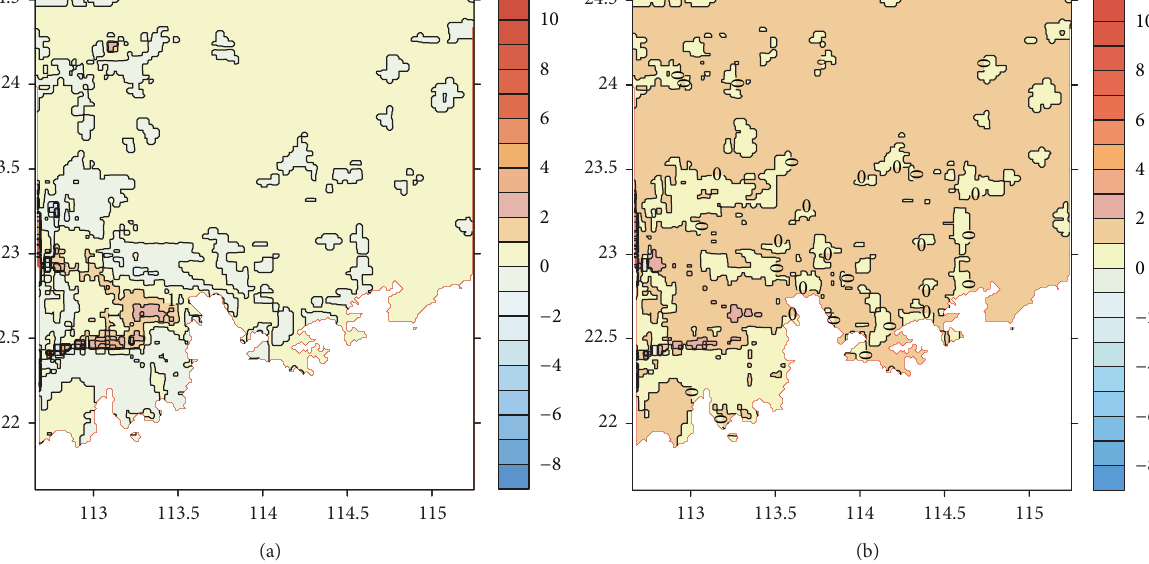
Figure 8: Spatial patterns of the change of precipitation in JJA and DJF from the year 2000 to the year 2020. The unit for precipitation is mm. (a) JJA; (b)